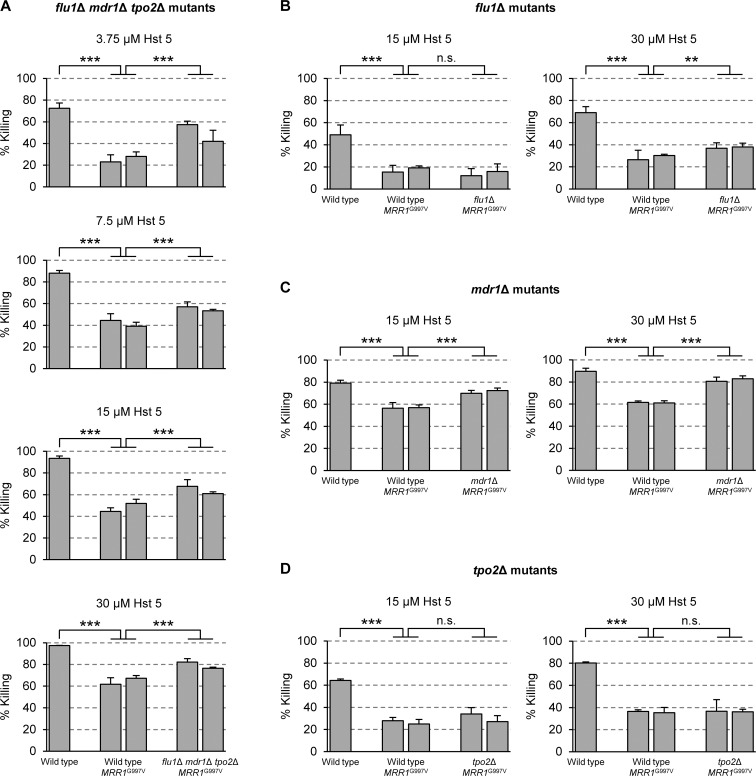
Mrr1-mediated Hst 5 resistance is mainly caused by MDR1 overexpression.Strains were incubated in the presence of the indicated Hst 5 concentrations and the percent killing was determined as described in Materials and Methods. The different mutants were tested on separate occasions and compared with the wild-type controls. (A) Hst 5 sensitivity of strains containing the hyperactive MRR1G997V allele in wild-type and flu1Δ mdr1Δ tpo2Δ triple mutant backgrounds. (B-D) Hst 5 sensitivity of strains containing the hyperactive MRR1G997V allele in wild-type and (B) flu1Δ, (C) mdr1Δ, and (D) tpo2Δ single mutant backgrounds. The following strains were used in these experiments: SC5314 (Wild type), SCMRR1R44A and -C (Wild type, MRR1G997V), SC∆flu1∆mdr1∆tpo2MRR1R44A and -B (flu1Δ mdr1Δ tpo2Δ, MRR1G997V), SCΔflu1MRR1R44A and -B (flu1Δ, MRR1G997V), SCΔmdr1MRR1R44C and -D (mdr1Δ, MRR1G997V), SCΔtpo2MRR1R44A and -B (tpo2Δ, MRR1G997V). Significant differences (ANOVA) are marked with asterisks (** P < 0.01, *** P < 0.001); n.s., not significant (P > 0.05).